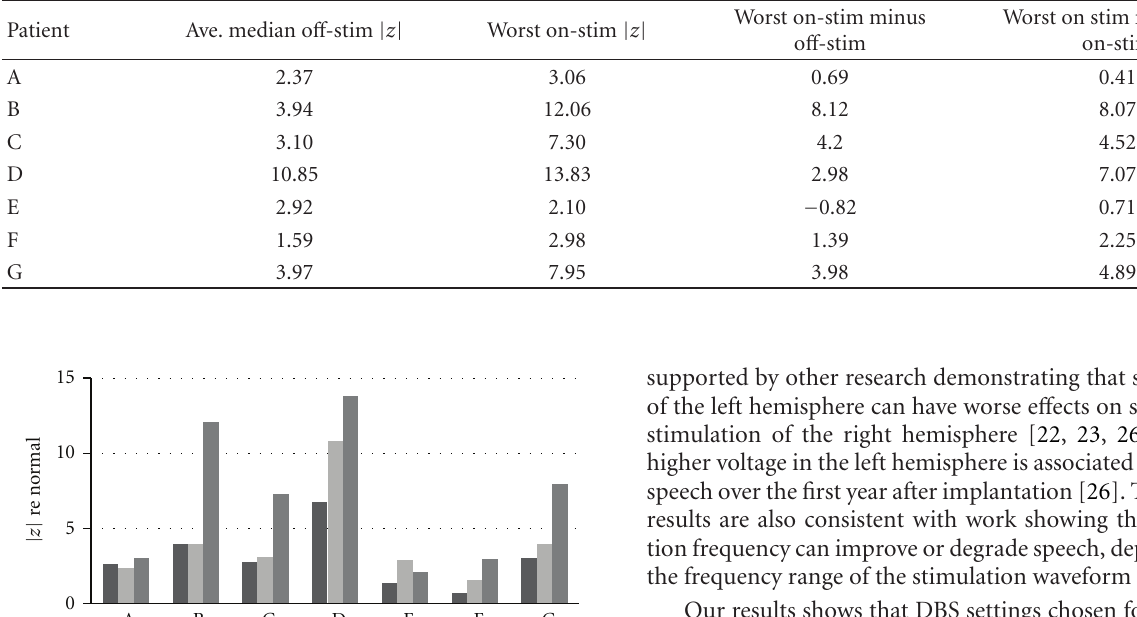
Table 9: Worst e ff ect of DBS on speech.